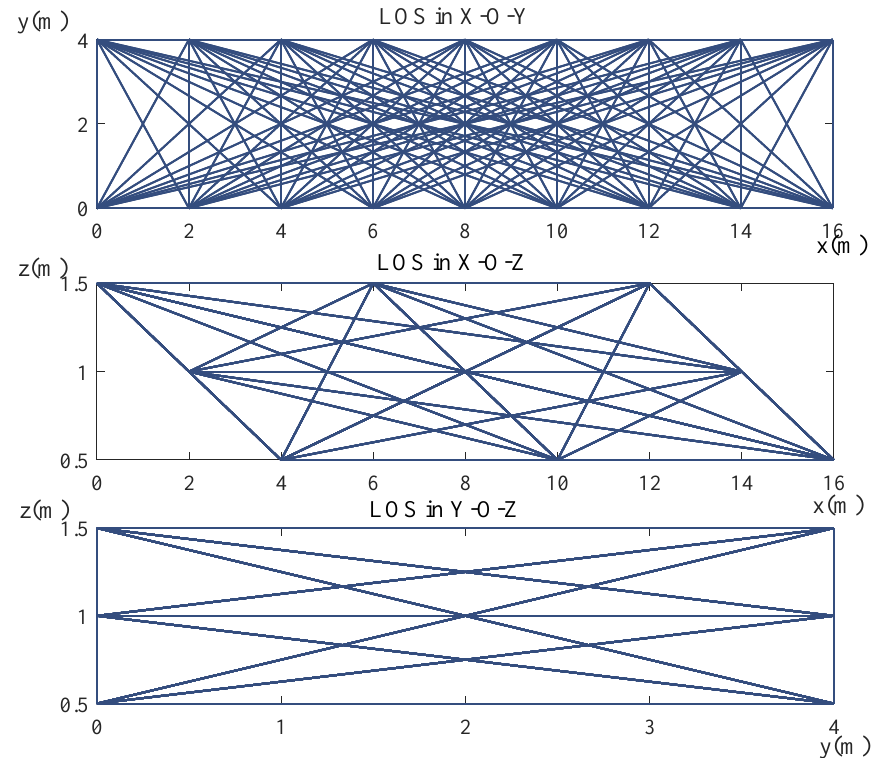
Figure 2. The projection density of wireless communication links on the X-O-Y plane, the X-O-Z plane, and the Y-O-Z plane,